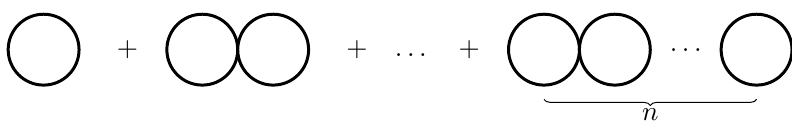
Figure 1 . Diagrams contributing to I ( x, x ′ ) at the same order in 1 /N